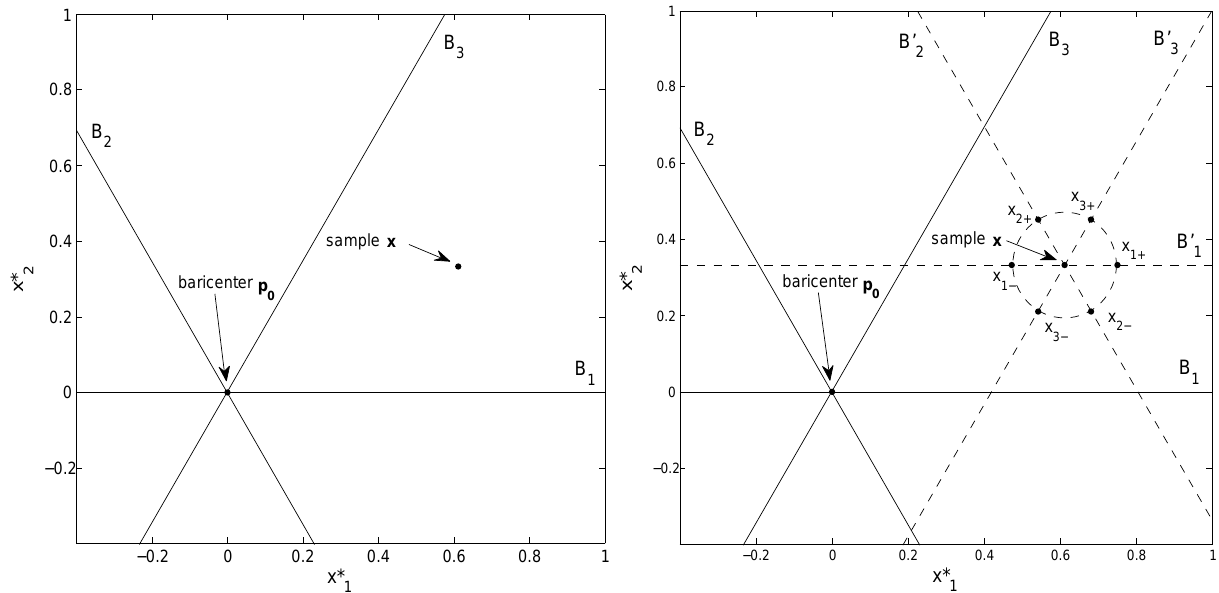
Fig. 2. (a) Representation of the barycenter p 0 , the sampled composition x and the bisectors B 1 , B 2 and B 3 after ILR transformation and (b) illustration of perturbation in the 2-D Euclidean space with indication of the perturbed compositions { x i + ,x i − } and the translated bisectors B 0 , B 0 and B 0 . 1 2 3